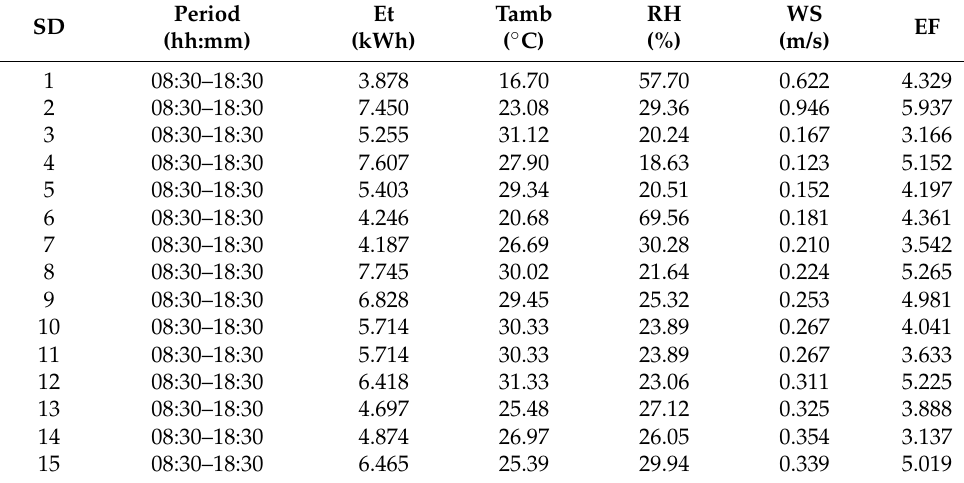
Table 5. Test dataset of predictors and the desired output of the hybrid DX-SAHP water heater. Period SD